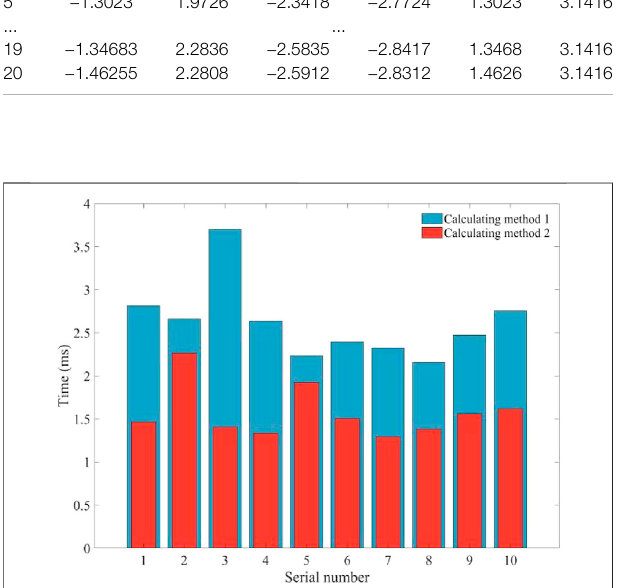
FIGURE 6 | Time results for ten calculations of the two inverse solution